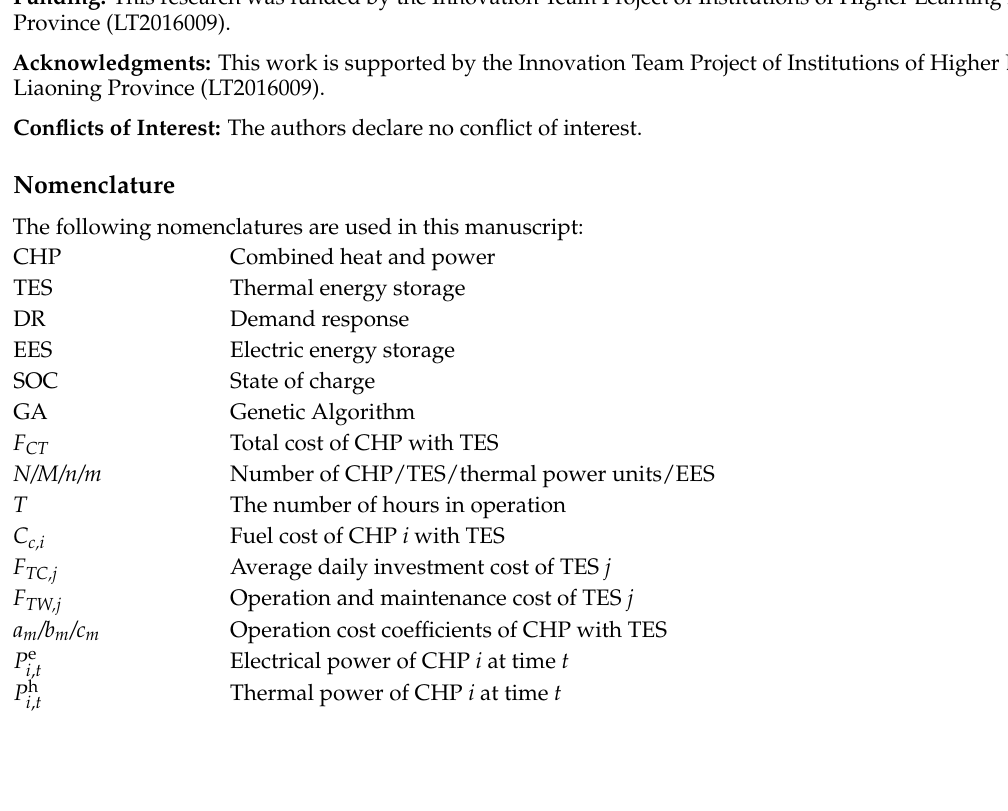
Figure 16. Wind power forecast and accommodation power.